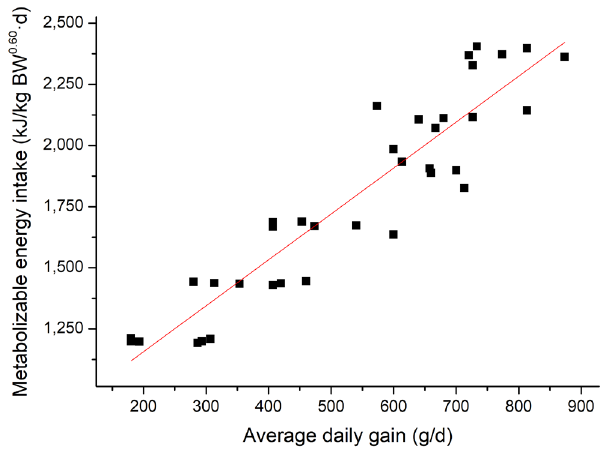
Figure 3. Linear relationship (parameters±standard error) between metabolizable energy intake (MEI) and average daily gain (ADG) for all pigs ( ■ ). MEI, kJ/kg BW 0.60 d = 1.88 (±0.128)×ADG, g/d +782 (±72.848), R 2 = 0.86, p<0.01, n =